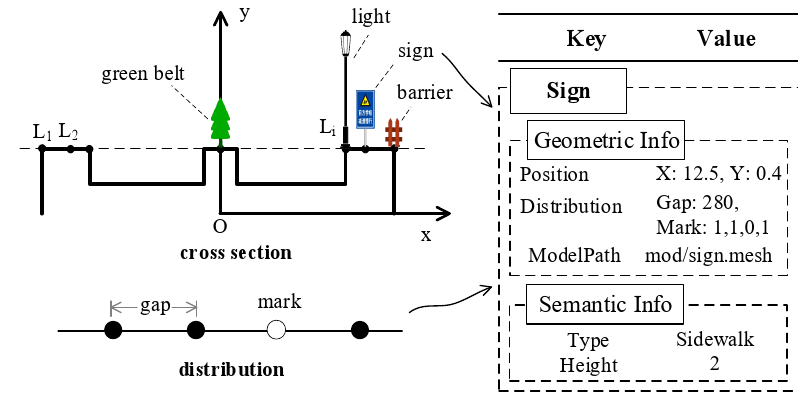
Figure 6. Road facility template.